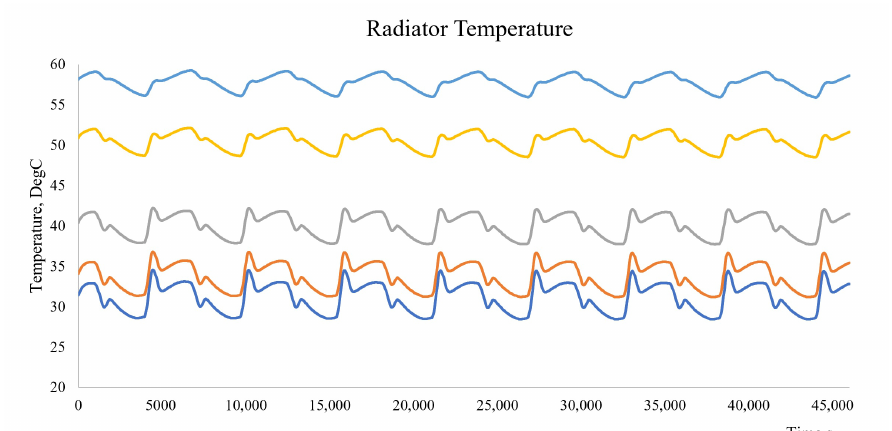
Figure 21. 6U Satellite deployable radiator with Thermal Straps—Radiator